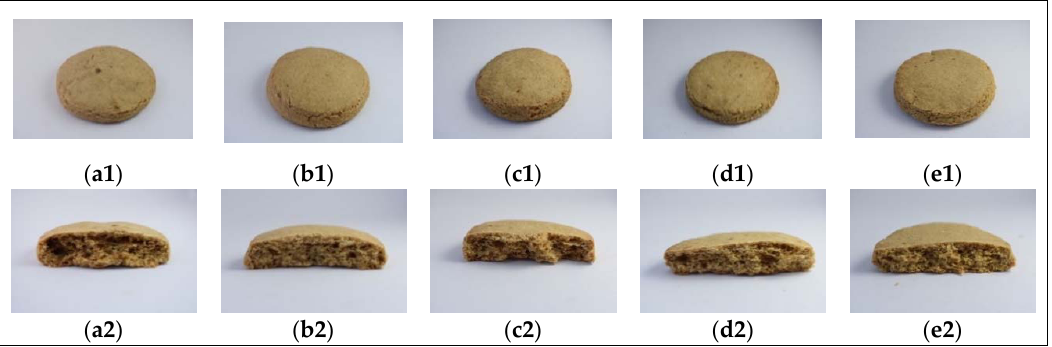
Figure 1. Photographs of cookies formulated using different levels of wheat flour substitution with orange by ‐ product flour (OBPF). ( a ) control; ( b ) 5%; ( c ) 10%; ( d ) 15%; and ( e ) 20%; ( 1 ) upper image; and ( 2 ) cross ‐ sectional image.